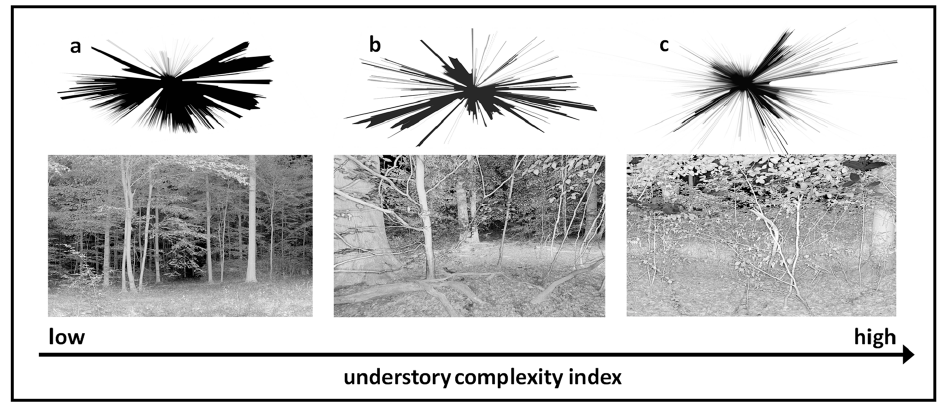
Figure 4. Exemplary horizontal cross-sectional polygons and corresponding images of stands with a low ( a ); intermediate ( b ), and high understory complexity index (UCI) value ( c ).